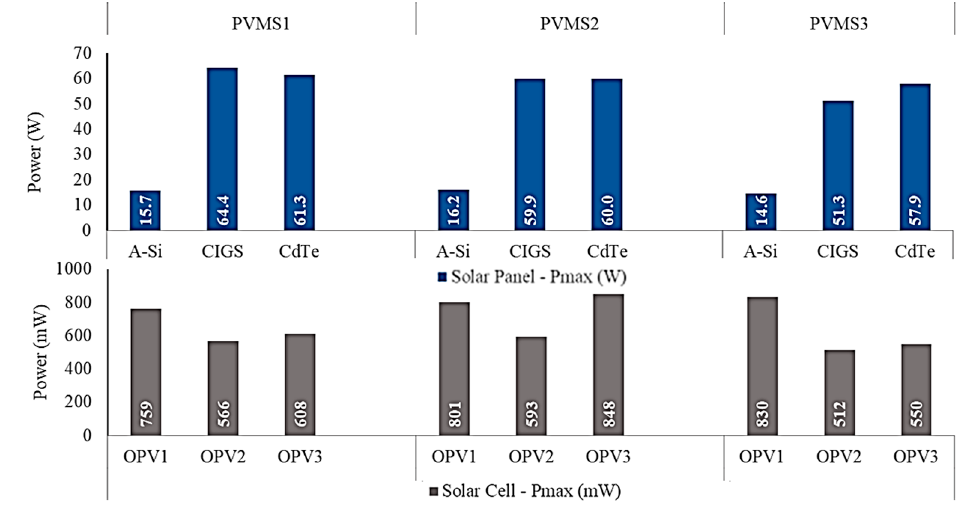
Figure 6. Pmax generated by each PV/OPV technology in PVMSs for Irr = 1033 (W/m 2 ).